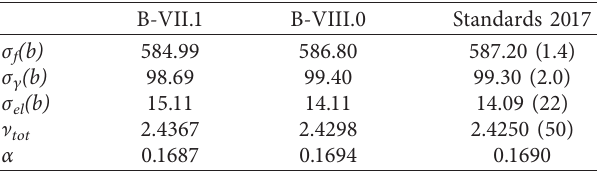
Figure 2: Mixed fuel with uranium and thorium in the 4.95% enrichment pattern core configuration.